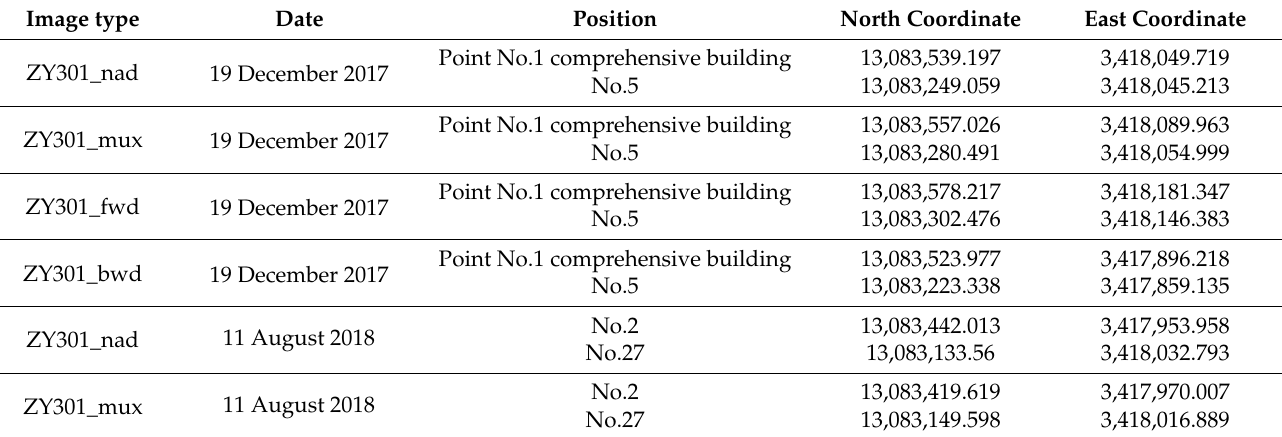
Table 4. High-resolution image-processing